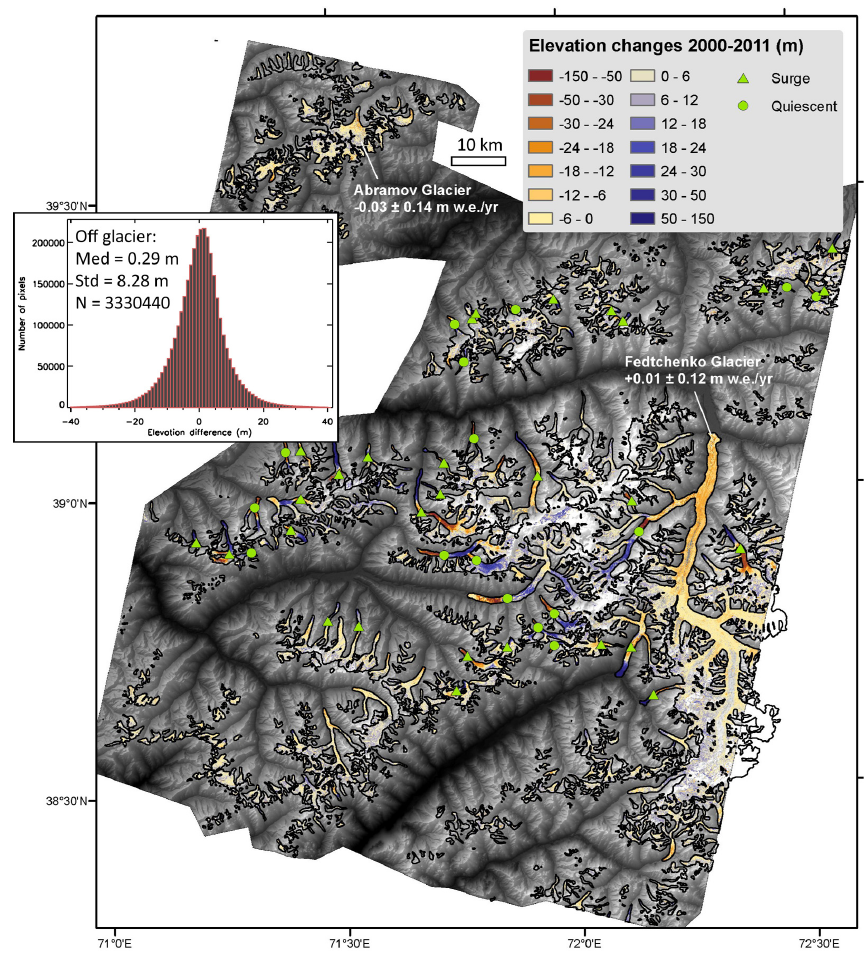
Fig. 10. Same as Fig. 8 but for the Pamir study